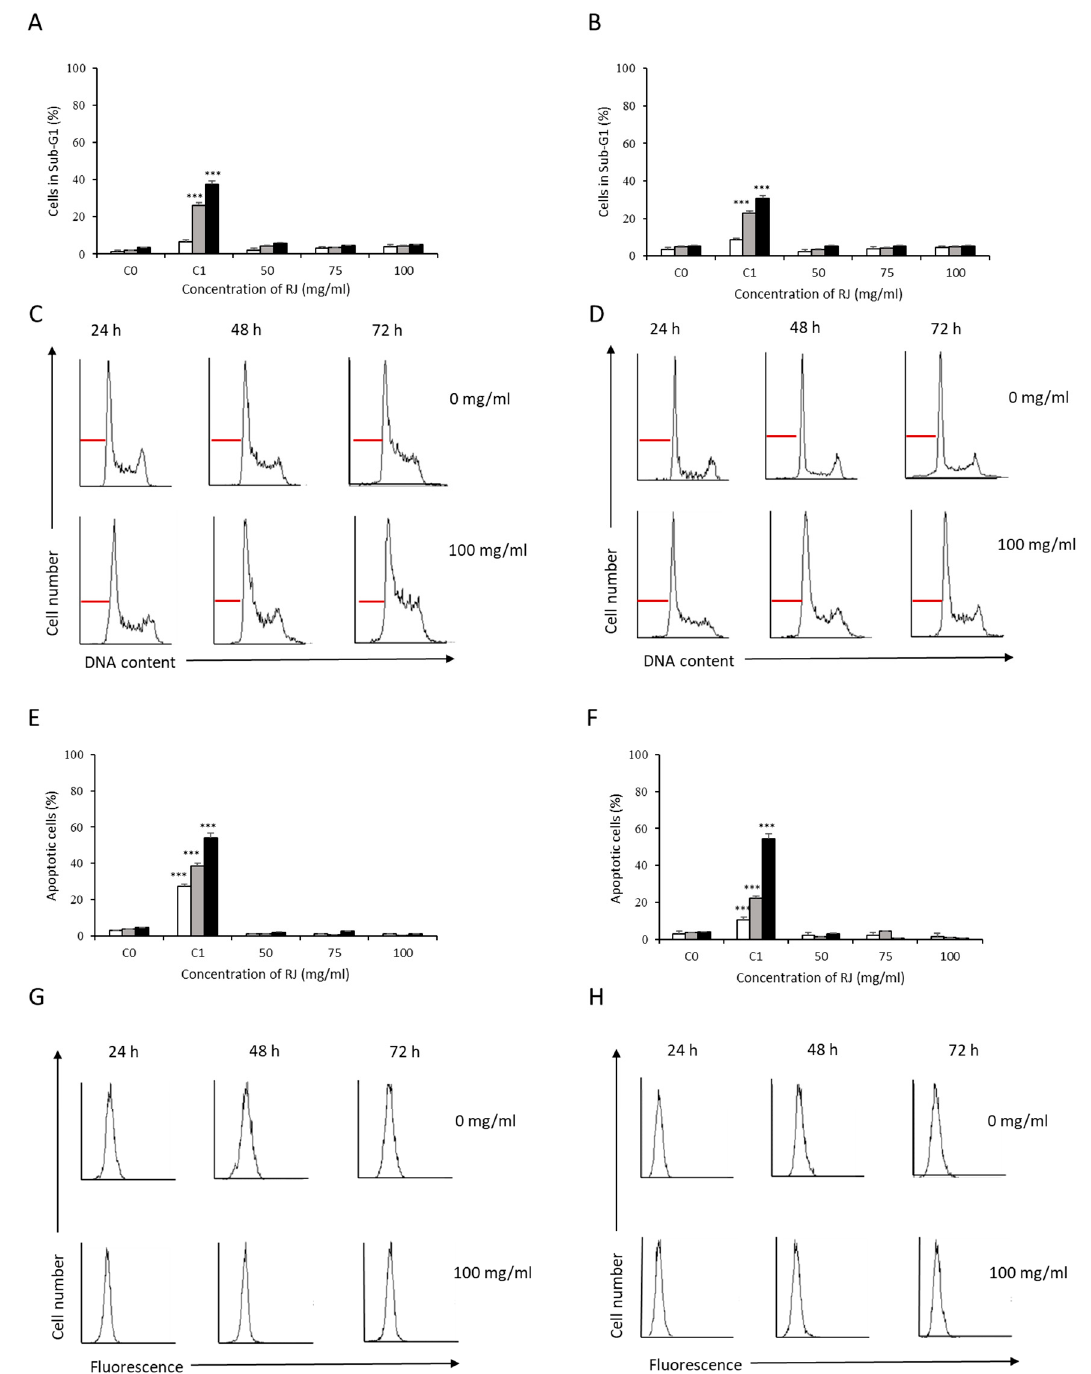
Figure 6. Effect of sample 15 (RJ) on human liver cell apoptosis. The cell cycle was determined using flow cytometry. HepG2 ( A ) and WRL-68 ( B ) cells were treated with different doses of sample 15 (50, 75, and 100 mg/mL) for 24 ( □ ), 48 ( ■ ), and 72 h ( ■ ). Representative histograms of the cell cycle of HepG2 ( C ) and WRL-68 ( D ) cells are shown; the red line indicates the sub-G1 phase. The percentage of apoptosis was analyzed by flow cytometry using the TUNEL assay. HepG2 ( E ) and WRL-68 ( F ) cells were cultured with different doses of sample 15 (50, 75, and 100 mg/mL) for 24 ( □ ), 48 ( ■ ), and 72 h ( ■ ). Representative histograms of the fluorescence intensity in HepG2 ( G ) and WRL-68 ( H ) cells are presented. C 0 , untreated cells; C 1 , cells treated with etoposide (50 µM). Asterisks indicate a significant difference from the control (C 0 ). *** p ≤ 0.001.